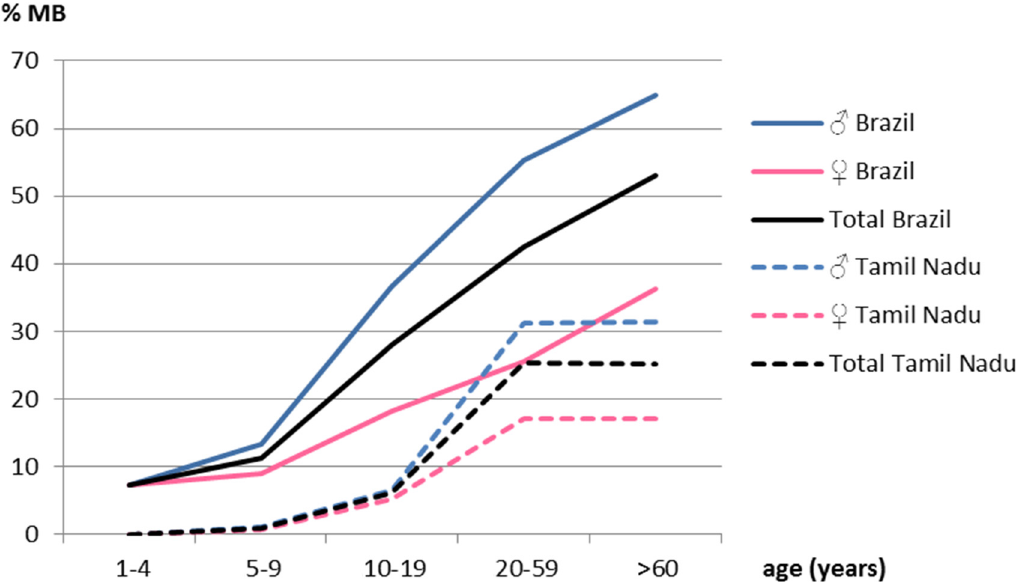
Fig 2. Proportion of multibacillary patients according to age and sex. Proportion of multibacillary patients according to age and sex are given for two distinct geographic areas: (1) in Brazil, 40,544 PB and 29,764 MB cases (Madrid classification) were declared over the 2006 – 2010 period (national data) [28]; (2) in Tamil Nadu (India), during the 1962 – 1970 period, 3,963 PB and 1,258 MB cases were collected out of a total of 276,568 persons screened for leprosy (Madrid classification)